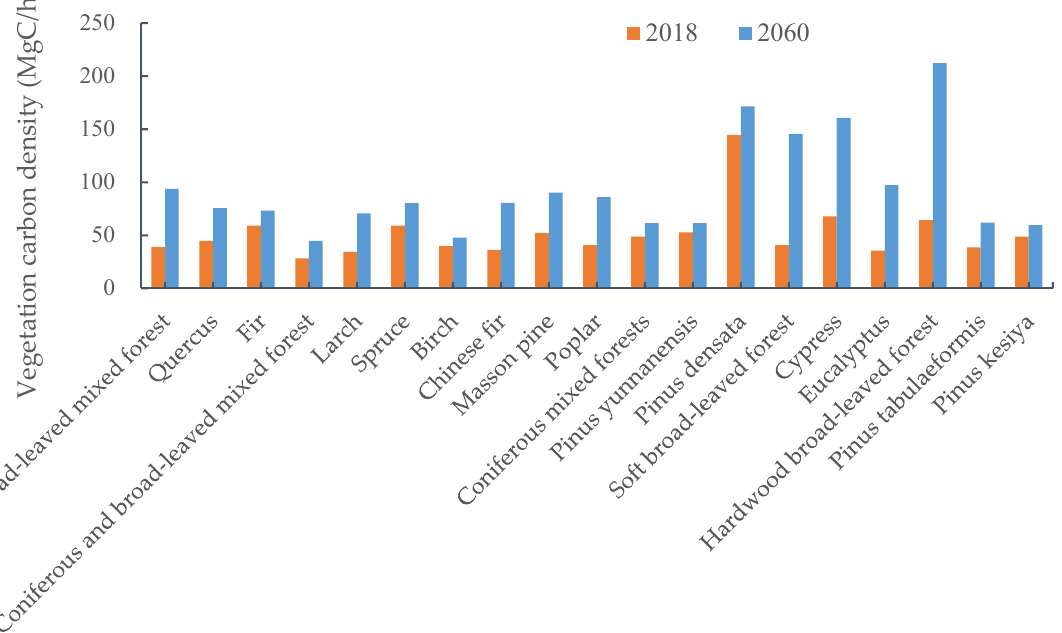
Figure 1. Vegetation carbon density of dominant tree species in China’s existing arbor forests.